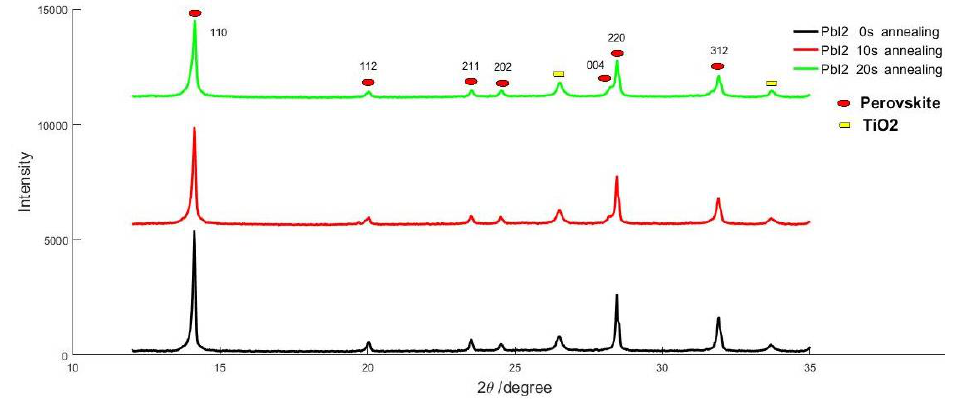
Figure 3. X-ray diffraction (XRD) patterns of perovskite films prepared by sequential deposition route with different PbI 2 annealing times.